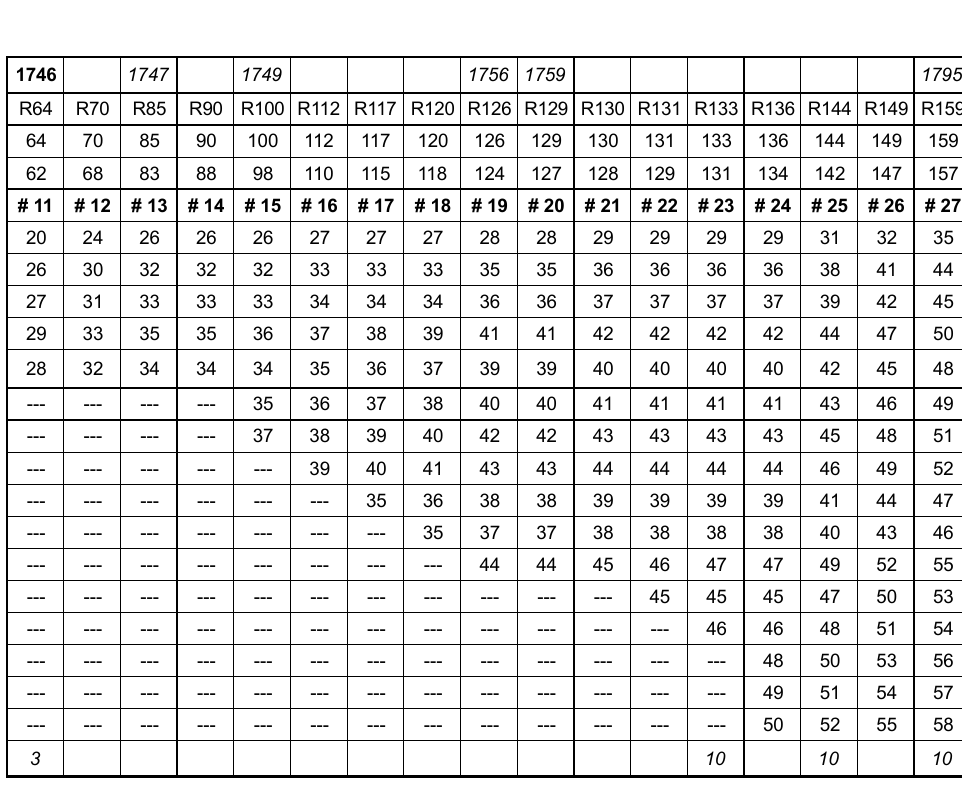
Table 1. Atlas selectus : (1) Editions, dating, number of leaves / maps. (2) Maps of Silesia: location in the